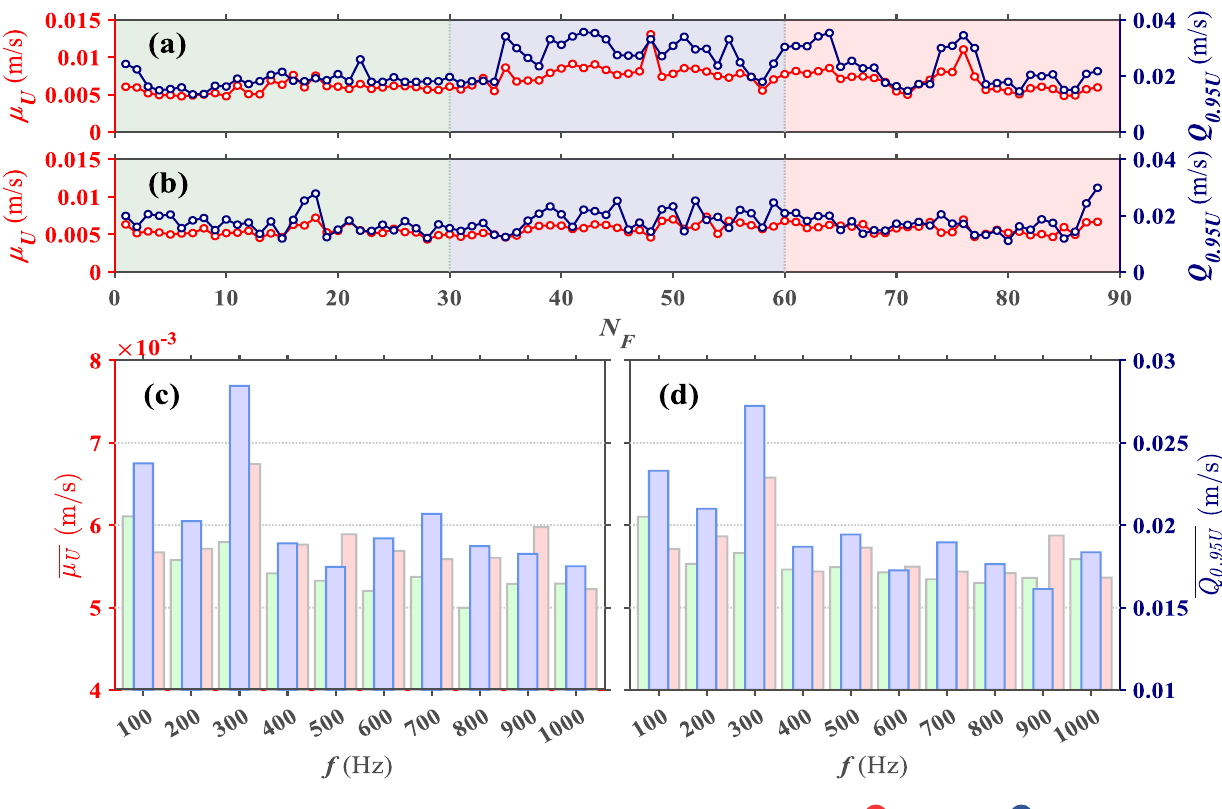
Figure 2. Statistics of larvae velocity in response to sound stimuli. Time series plot of : mean and : 95th percentile at ( a ) f = 300 Hz and ( b ) f = 400 Hz where f is the frequency. Bar plot of ( c ) time averaged mean velocity and ( d ) time averaged 95 percentile velocity computed for : frames 1 – 29 (before sound tone), : frames 30 – 59 (during sound tone) and : frames 60 – 89 (after sound tone ceased).